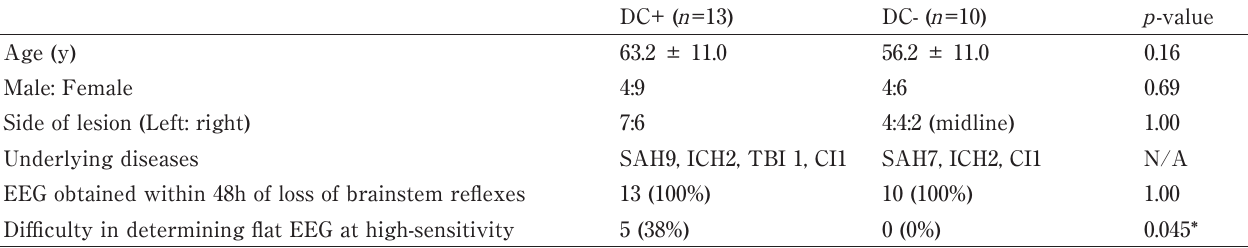
Table 1. Demographics of 23 patients with flat EEG at low-sensitivity